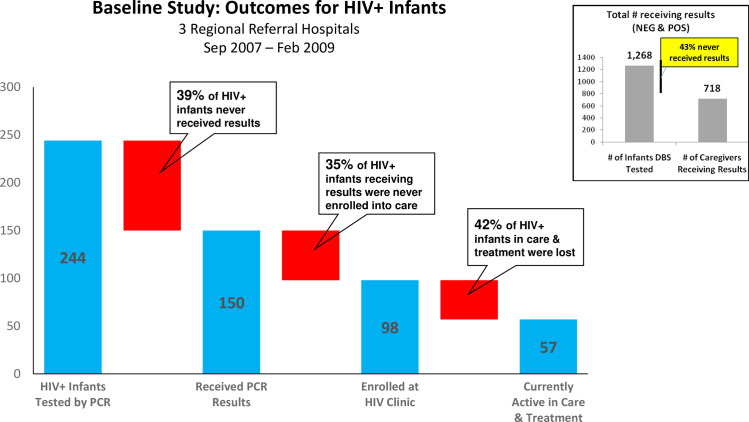
Baseline study: Outcomes for HIV+ infants.Graph showing the retention outcomes for HIV-exposed infants testing HIV-positive (n = 244) in the 2010 pre-intervention study. The red bars represent the number of infants lost to-follow up at each step in the EID cascade. The box in the top-right corner shows the percent of all tested HIV-exposed infants (n = 1268)—both negative and positive—who received their results.